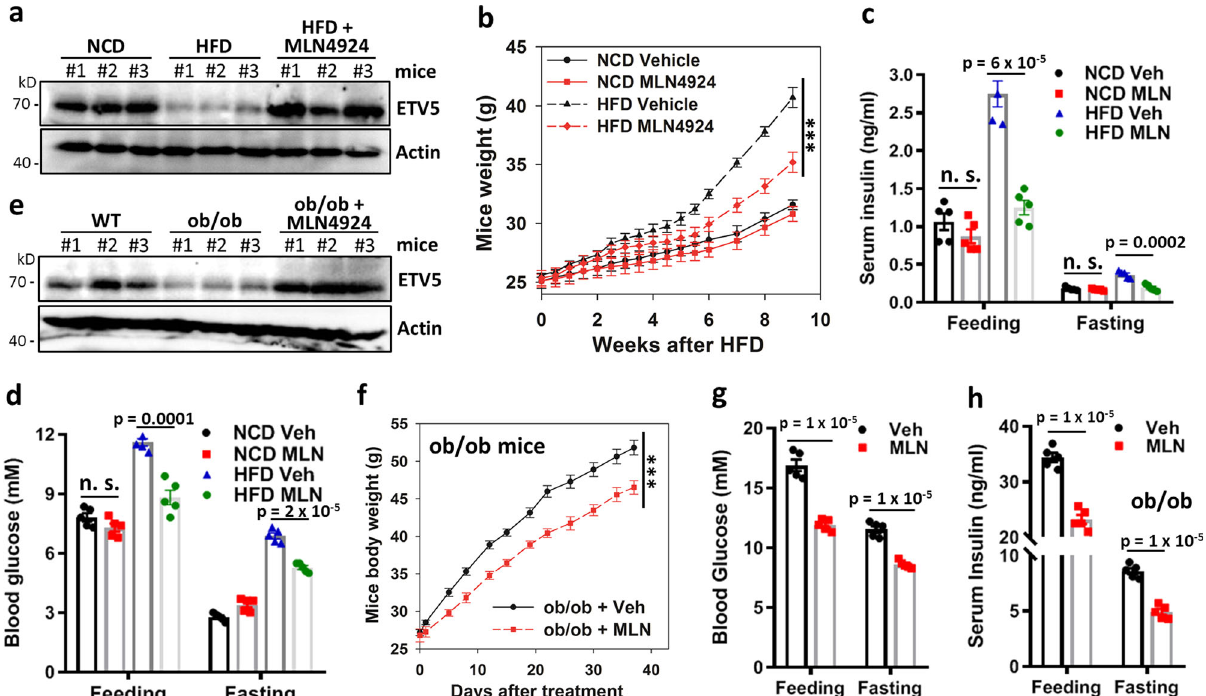
Fig. 7 The CRL inhibitor pevonedistat/MLN4924 stabilizes ETV5 and improves diet-induced or leptin de fi ciency-induced obesity/diabetes. a , e Levels of ETV5 in HFD-fed mice ( a ) or ob/ob mice ( e ), with/without MLN4924 treatment. b Body weight of 8-week-old WT mice fed HFD or NCD for the indicated time period, with/without MLN4924 treatment (15 mg/kg, twice weekly for the fi rst 6 weeks; n = 5, *** p < 0.001, calculated by two-way repeated measures ANOVA testing treatment × time effect). Data are presented as mean ± SEM. c , d Feeding and fasting insulin ( c ) and glucose ( d ) levels in HFD or NCD mice with/without MLN4924 treatment ( n = 5). Data are presented as mean ± SEM. P values were calculated by two-tailed Student ’ s t